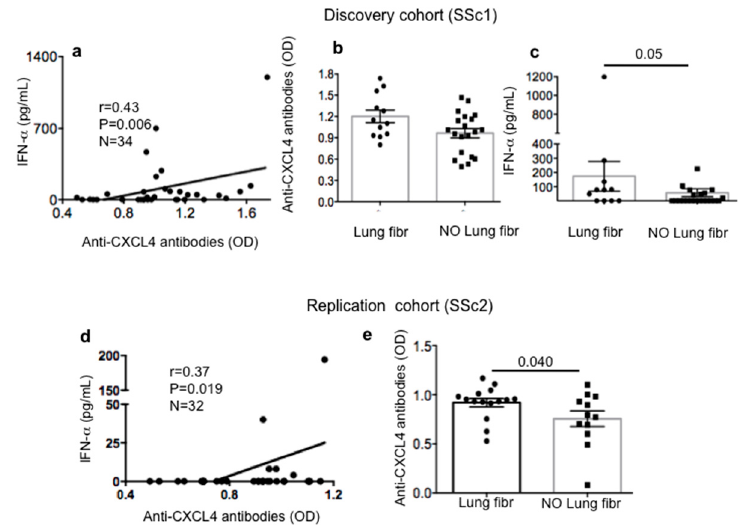
Figure 3. Anti-CXCL4 antibody reactivity correlates with circulating interferon (IFN)-I signature and is higher in patients with lung fibrosis. We measured IFN- α levels by ELISA in sera (discovery cohort) ( a ) or plasma (replication cohort) ( d ) of SSc patients and made a correlation with antibody response to CXCL4 tested by ELISA (OD). Correlation “ r ” was by Pearson’s test, significant p values and sample size n are indicated. Antibody reactivity to CXCL4 was compared between SSc patients with lung fibrosis (lung fibr) and patients with no lung fibrosis (NO lung fibr) ( b , e ) as well as circulating IFN- α levels (by ELISA) ( c ). In ( b , c , e ), horizontal bars are the means, vertical bars are standard error of the means, and p values are calculated by Mann–Whitney test.